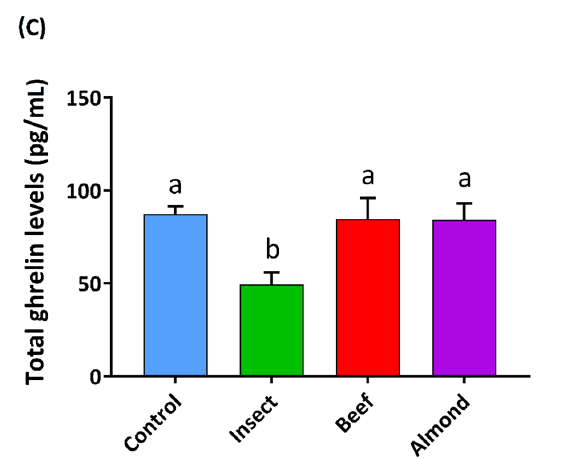
Figure 3. E ff ect of intestinal digestions of di ff erent foods (5 mg protein / mL) on total GLP-1 ( A ), PYY ( B ), Figure 3. Effect of intestinal digestions of different foods (5 mg protein/mL) on total GLP-1 ( A ), PYY ( B ), and total ghrelin ( C ) human colon secretion in explants. The incubation period was 30 min after 15 min of stabilization. The sample size was n = 10 for control and treatment groups. Results are expressed as the mean ± SEM. One-way ANOVA and Tukey’s post-hoc test were used for multiple comparisons. Different letters (a,b,c) indicate significant differences ( p -values < 0.05).